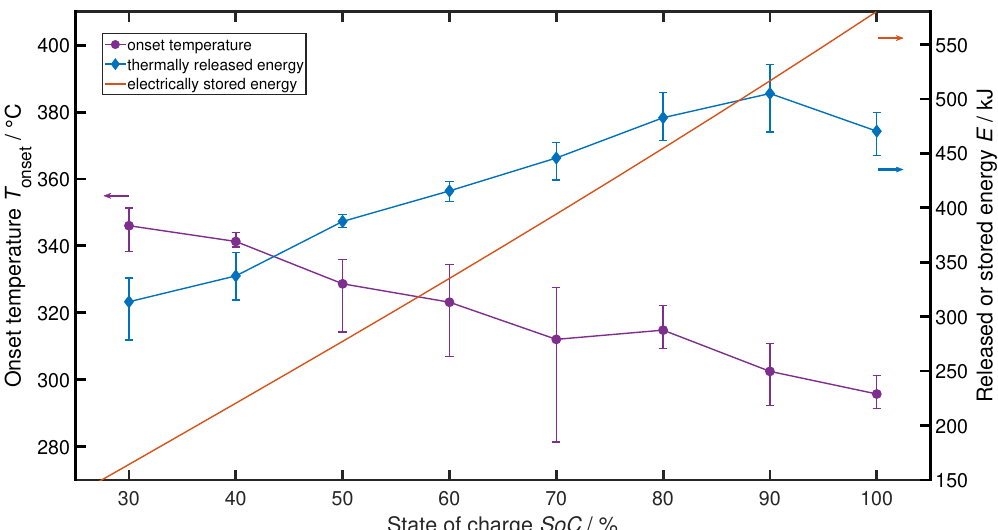
Figure 1. Impact of SoC on onset temperature T onset and thermally released energy E therm . The red line serves as a comparison to the electrically stored energy in the cell.